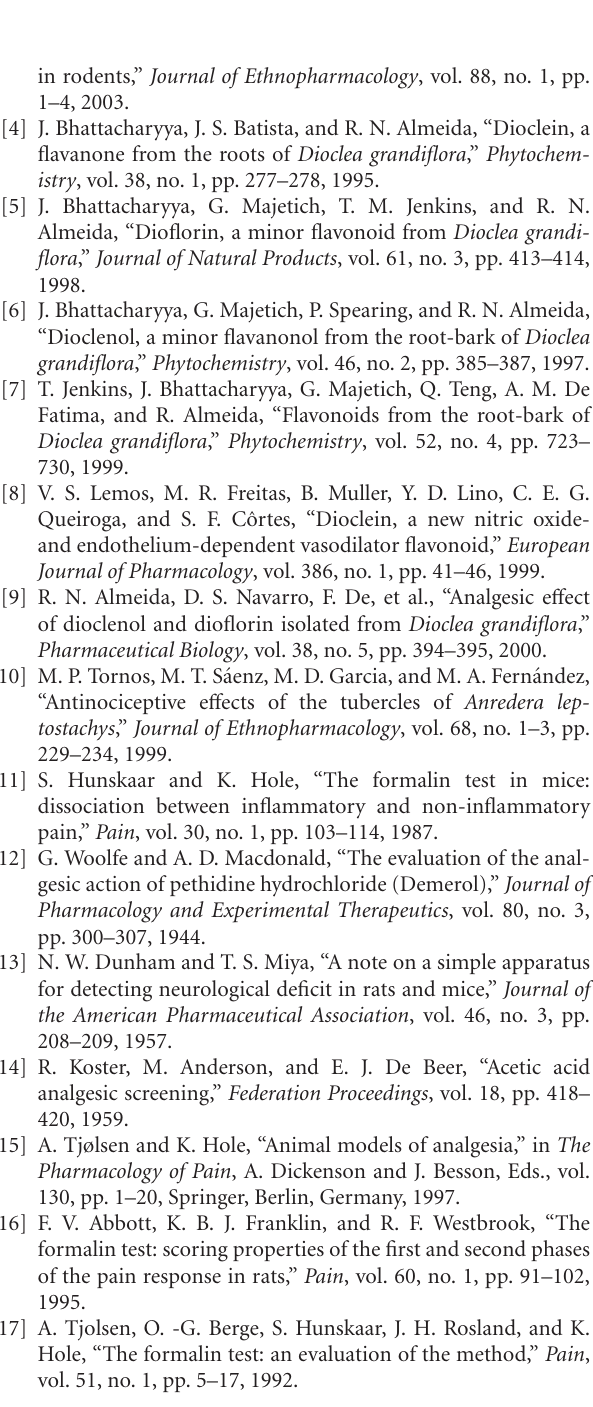
Control (10 mL/kg,